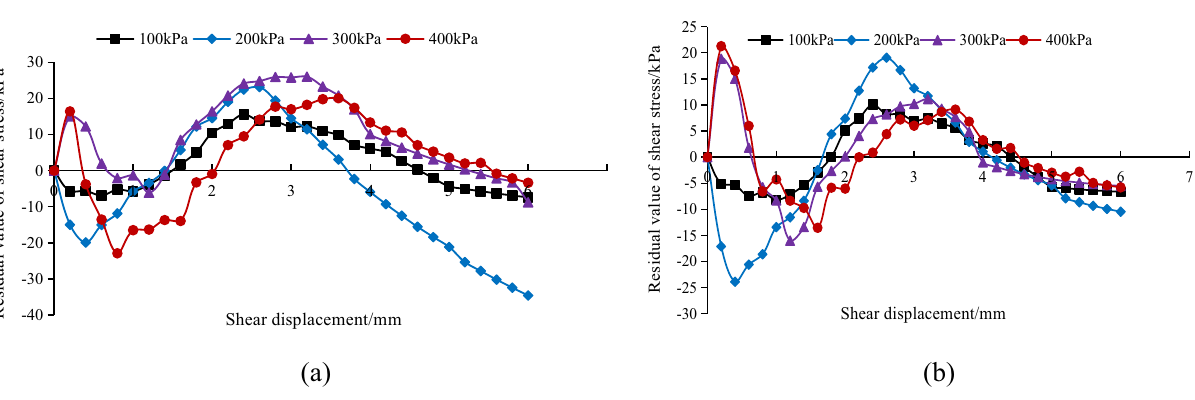
Figure 12. Residual shear stress of interface model under RS bonding strength. ( a ) The Clough–Duncan curve model; ( b ) the improved Gompertz curve model.